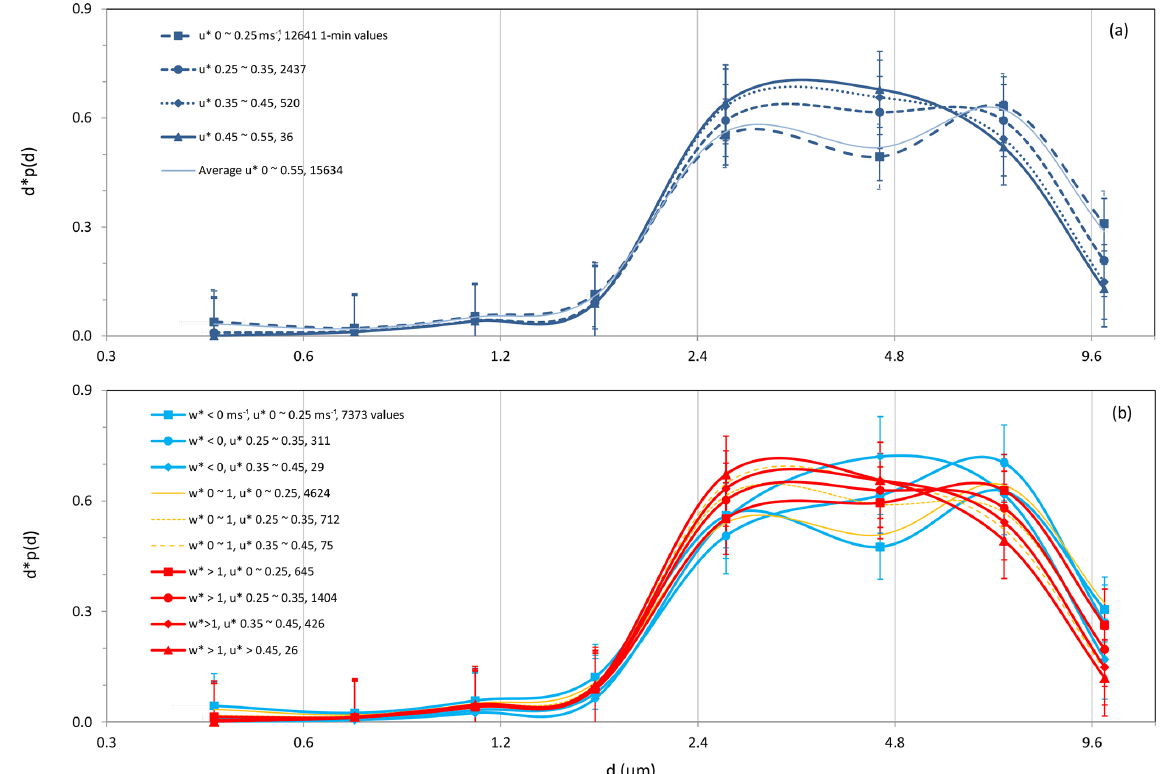
Figure 4. (a) Dust PSD for different u ∗ categories derived from the whole JADE dataset; (b) same as (a) but for the different u ∗ categories under stable ( w ∗ < 0), moderately unstable (0 ≤ w ∗ < 1ms − 1 ) and unstable ( w ∗ ≥ 1ms − 1 )